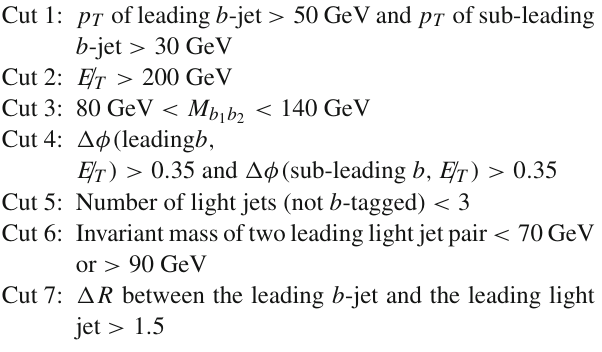
Table 6. The formula used for calculating signal significance is given in Eq.